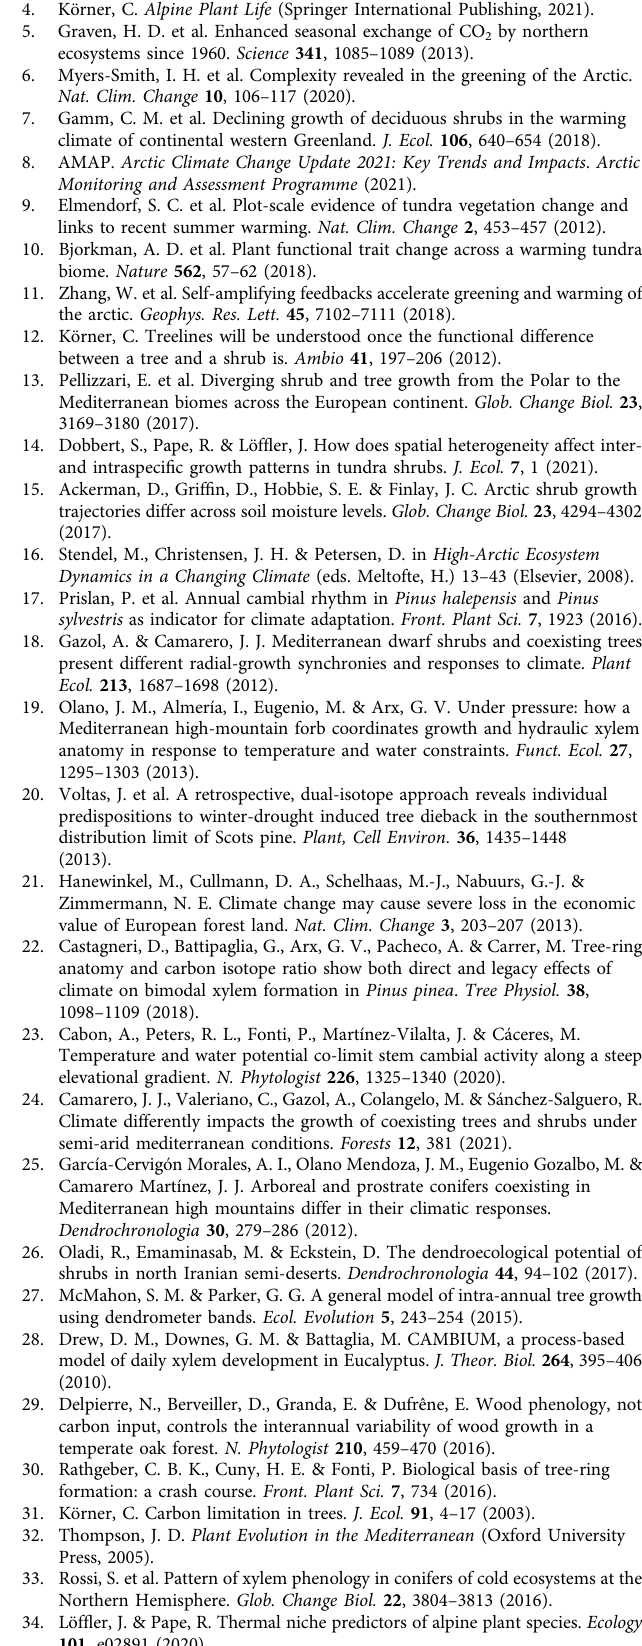
Table 2 Diagnostic information for the fi tted generalized additive models